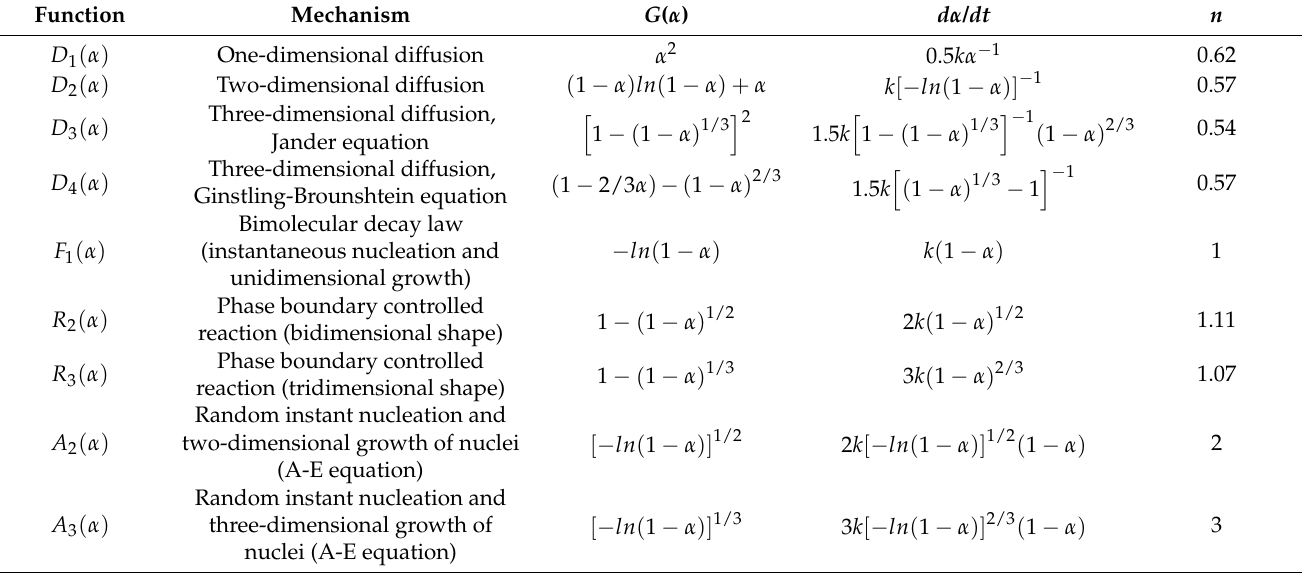
Table 2. Model function G ( α ) for normal solid-state reactions.